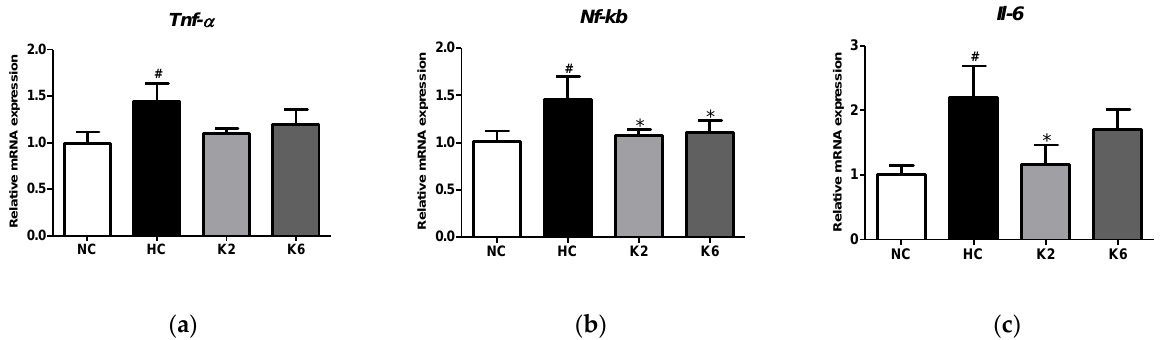
Figure 3. Effect of L. plantarum treatments on mRNA expression of inflammatory-related genes in the HFHF diet rat. mRNA expression level of ( a ) Tnf- α , ( b ) Nf- κ b , and ( c ) Il-6 in the small intestine. Values represent the mean ± SEM. # p < 0.05 vs. control group (NC), * p < 0.05 vs. HC group. NC, normal diet control; HC, HFHF diet control; K2, HFHF diet with K2; K6, HFHF diet with K6; Tnf- α , tumor necrosis factor-alpha; Nf- κ b , nuclear factor-kappa B; Il-6 , interleukin-6.